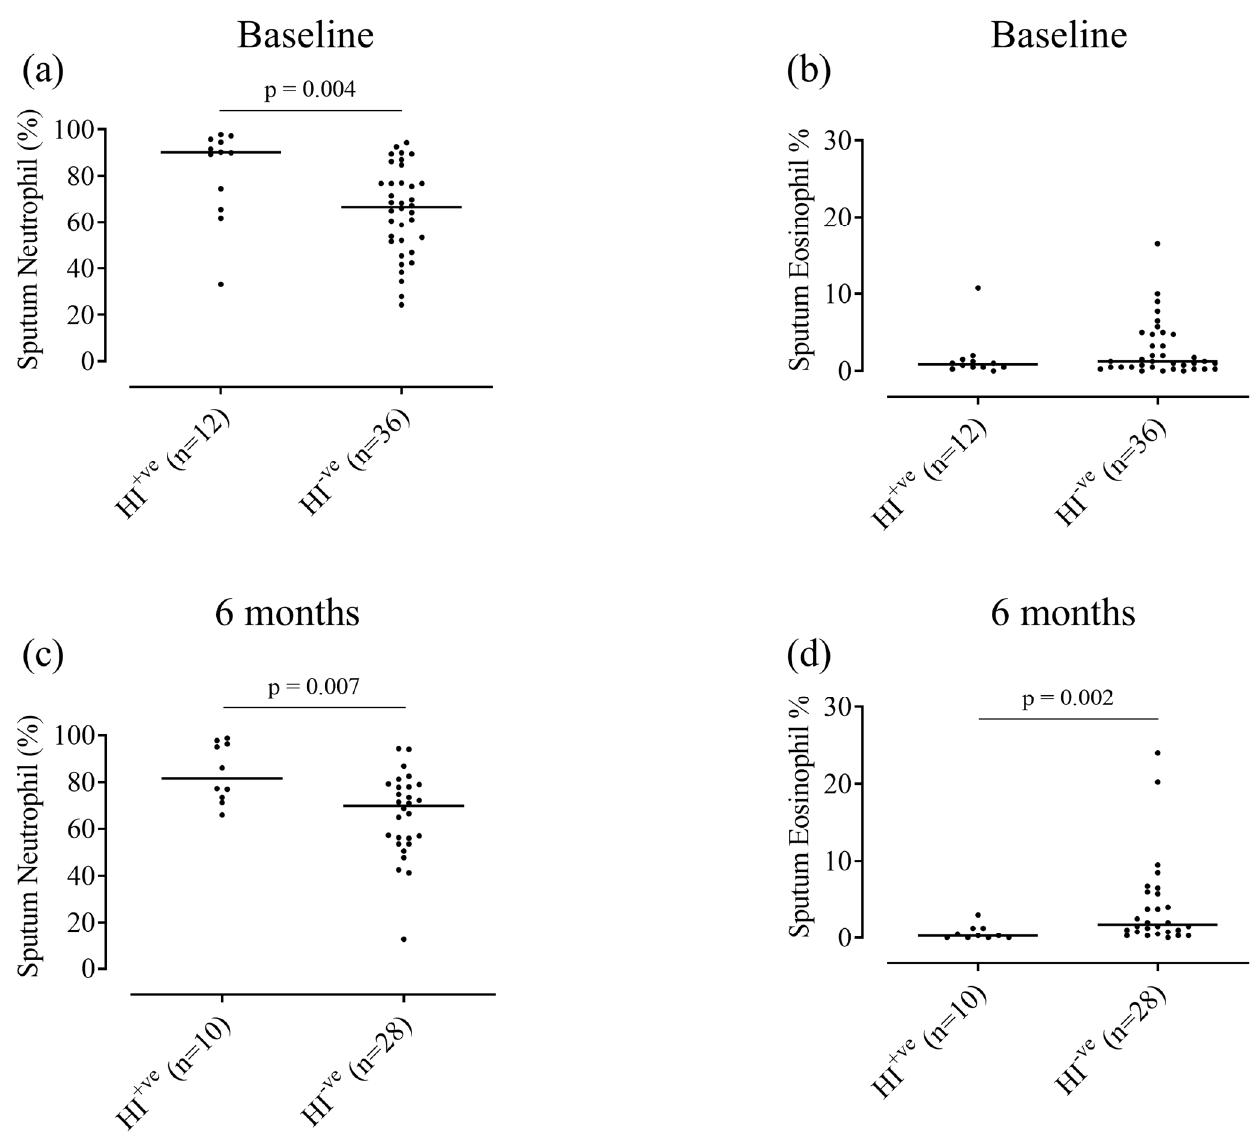
Figure 3. Sputum neutrophil and eosinophil percentages for Haemophilus influenzae -positive vs. -negative groups, at baseline and 6 months. Sputum differential cell counts were performed on H. influenzae -positive (HI +ve ) and H. influenzae -negative (HI − ve ) patients at baseline ( n = 12 and 36, respectively) and 6 months ( n = 10 and 28, respectively). Data represent sputum neutrophil or eosinophil percentages for individual patients ( a , b ) at baseline or ( c , d ) at 6 months. Solid black line represents median values. HI, Haemophilus influenzae